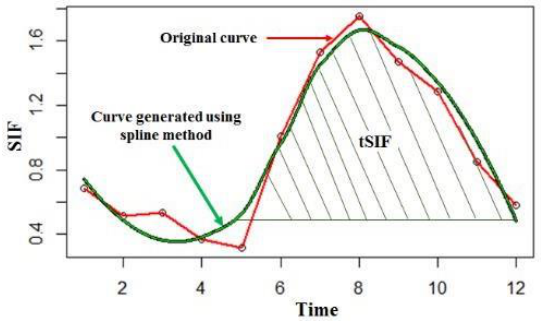
Figure 2. Time integrated SIF (tSIF) smoothened